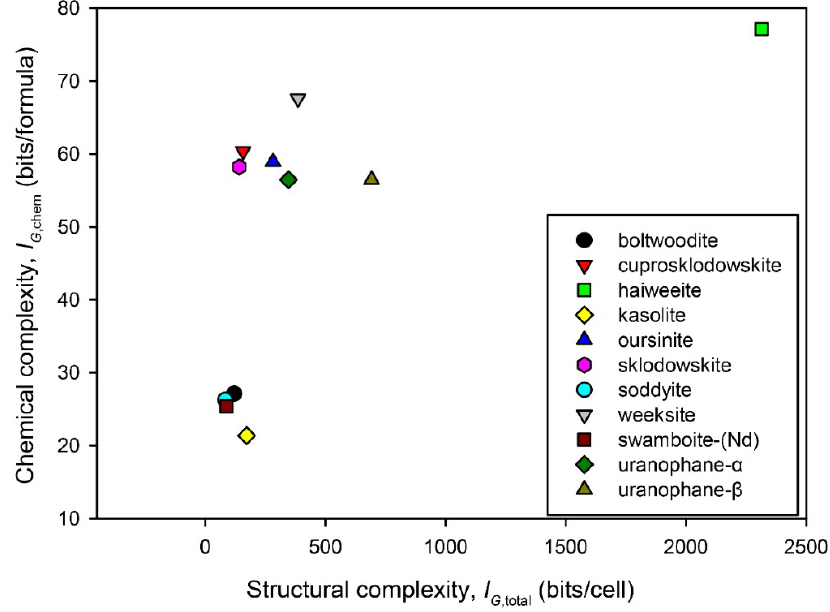
Figure 8. The relationship between the structural and chemical complexity of natural uranyl silicates (value of swamboite–(Nd) taken for the average structure; the value of the superstructure is taken as an outlier and is not shown).